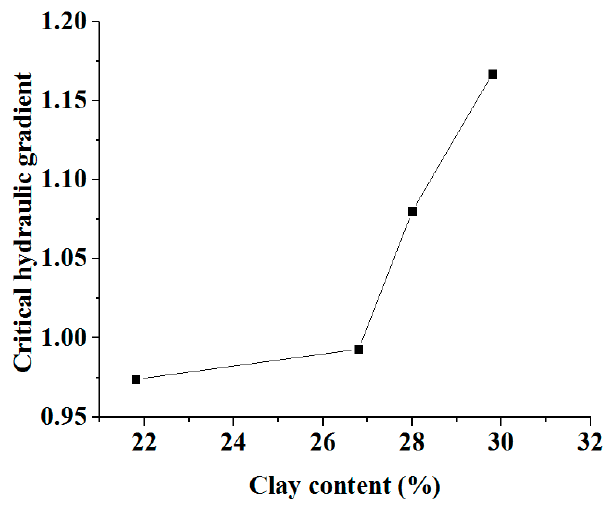
Figure 12. Critical hydraulic gradients for different clay contents.